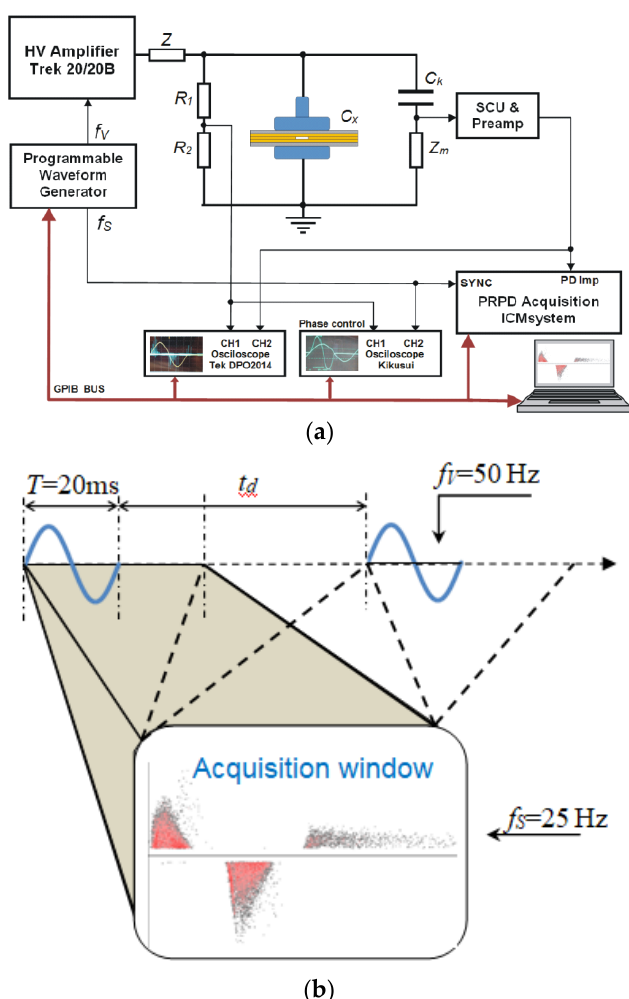
Figure 3. Partial discharge echo acquisition methodology using chopped sequence ( a ) experimental